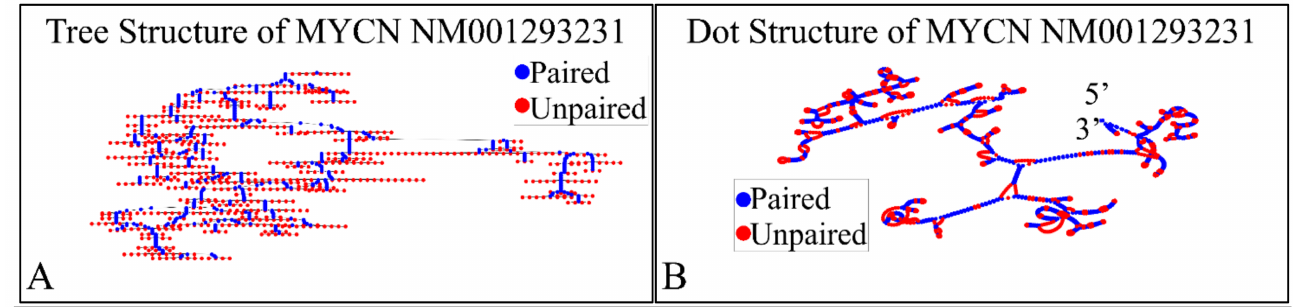
Figure 10. The predicted secondary structure of the MYCN , NM001293231 transcript. In particular, the tree structure ( A ) and the dot structure ( B ) of the transcript are presented (predictions were performed with the Matlab ® (The Mathworks, Inc. Natick, MA, USA), using the RNAfold method).